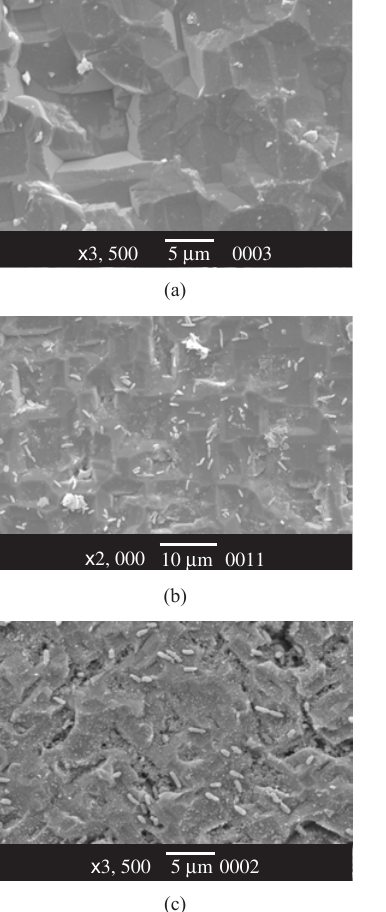
Figure 9. SEM microphotographs of Si after different exposure periods: a) t = 0; b) t = 30 minutes; and c) t = 1